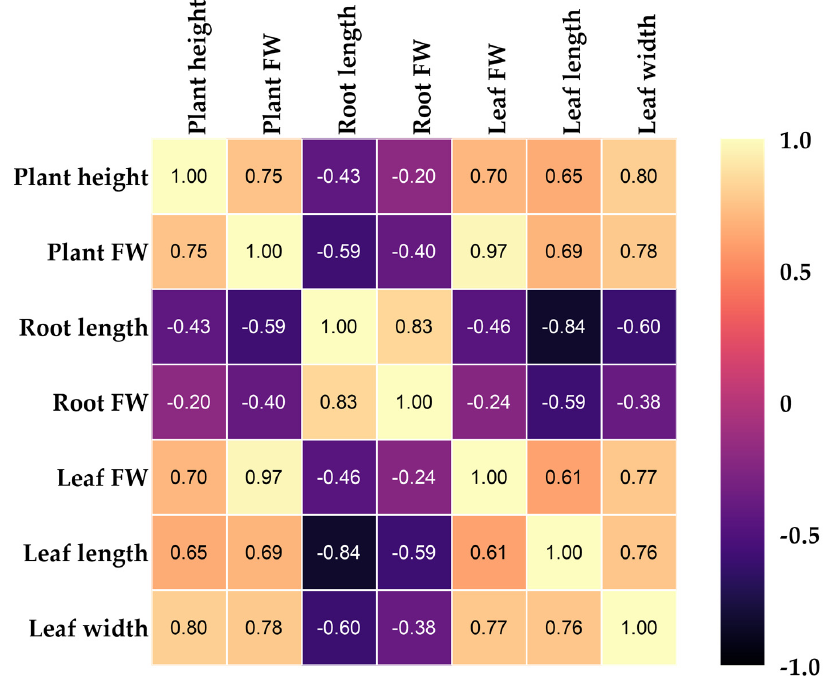
Figure 2. Correlation analysis of agronomic attributes corresponding to the treatments.